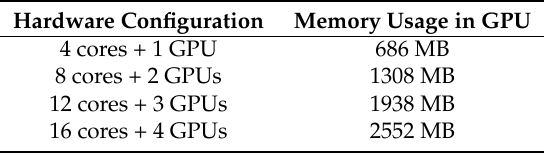
Table 4. Additional memory